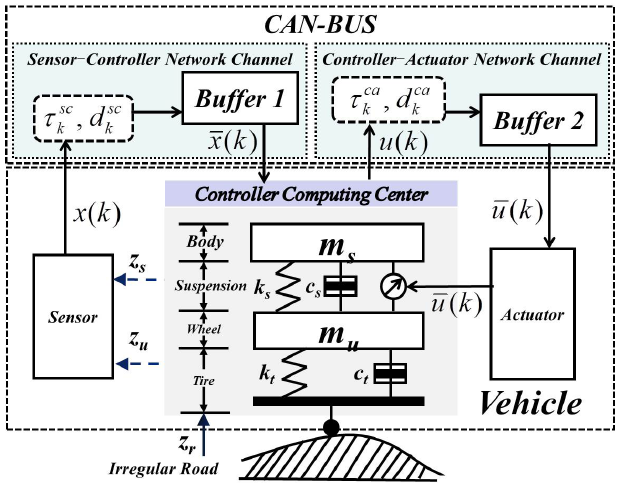
Figure 1. The quarter networked vehicle active suspension under imperfect CAN